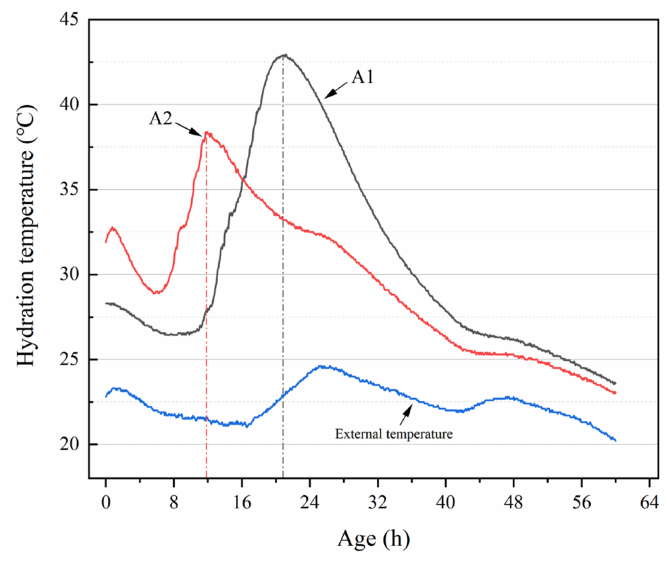
Figure 17. Hydration temperature of UHPC based on composite cementitious